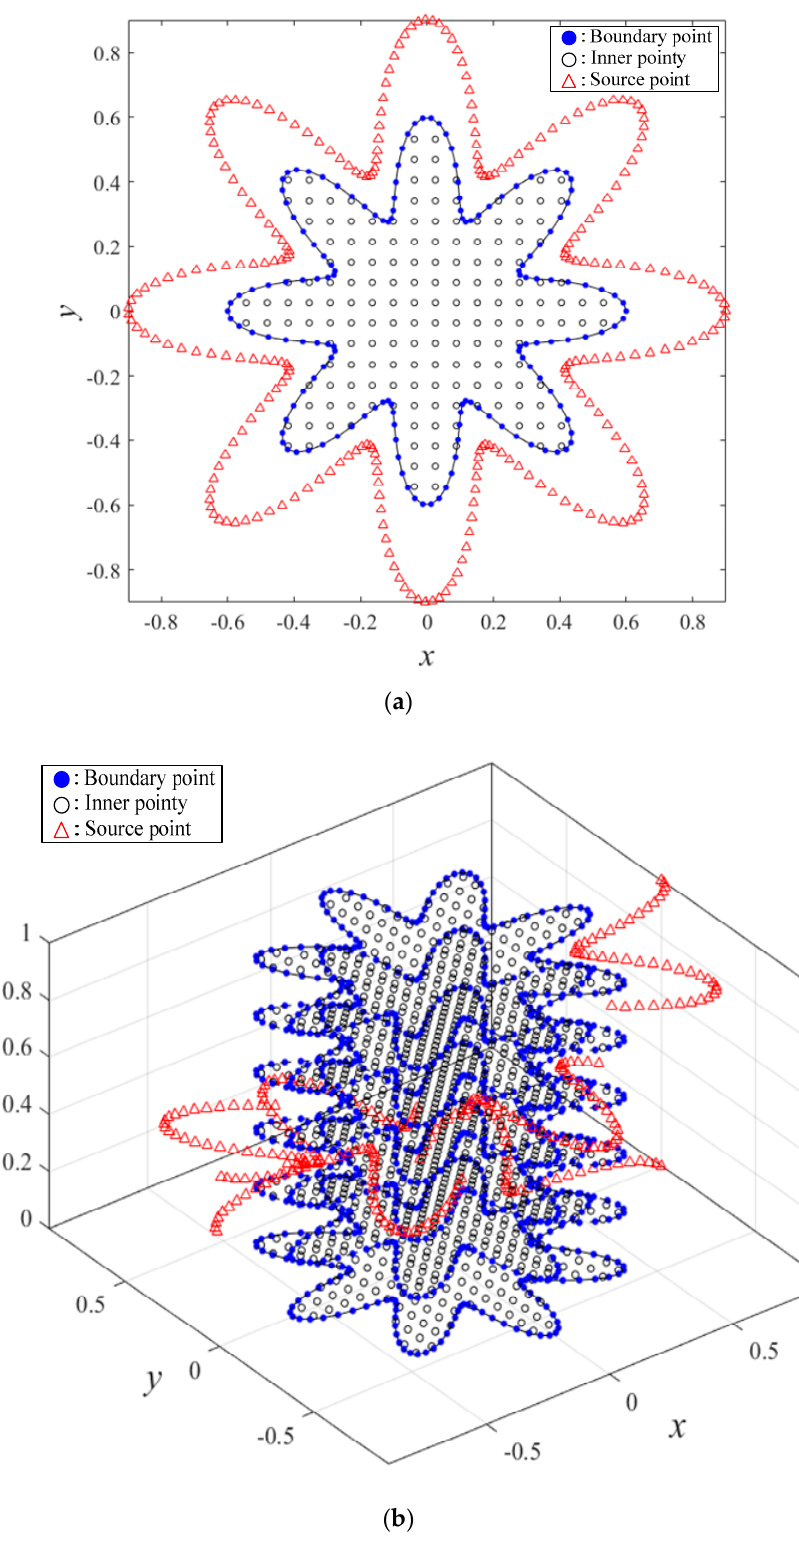
Figure 14. Collocation scheme of the proposed approach for example 4.3 projected on ( a ) an x – y plane and ( b ) space–time coordinates.